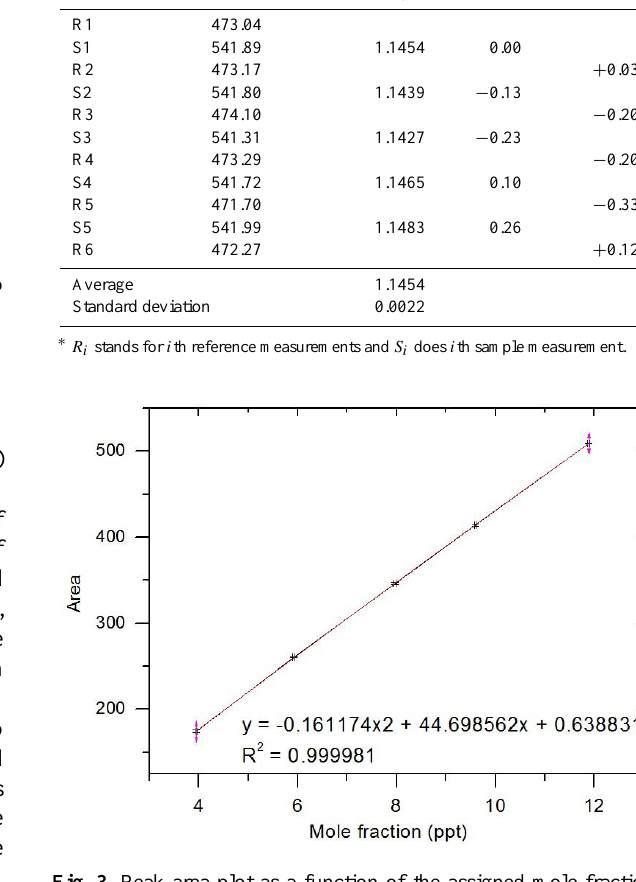
Fig. 3. Peak area plot as a function of the assigned mole fraction Figure 3 Peak area plot as a function of the assigned mole fraction of the WMO standards. 2 of the WMO standards. The response curve was approximated by a The response curve was approximated by a least square fit of a second order polynomial with 3 least square fit of a second-order polynomial with an agreement of R 2 = 0 . 99981. Residuals are listed in Table a goodness of R 2 = 0.99981. Residuals are listed in Table 2. 4